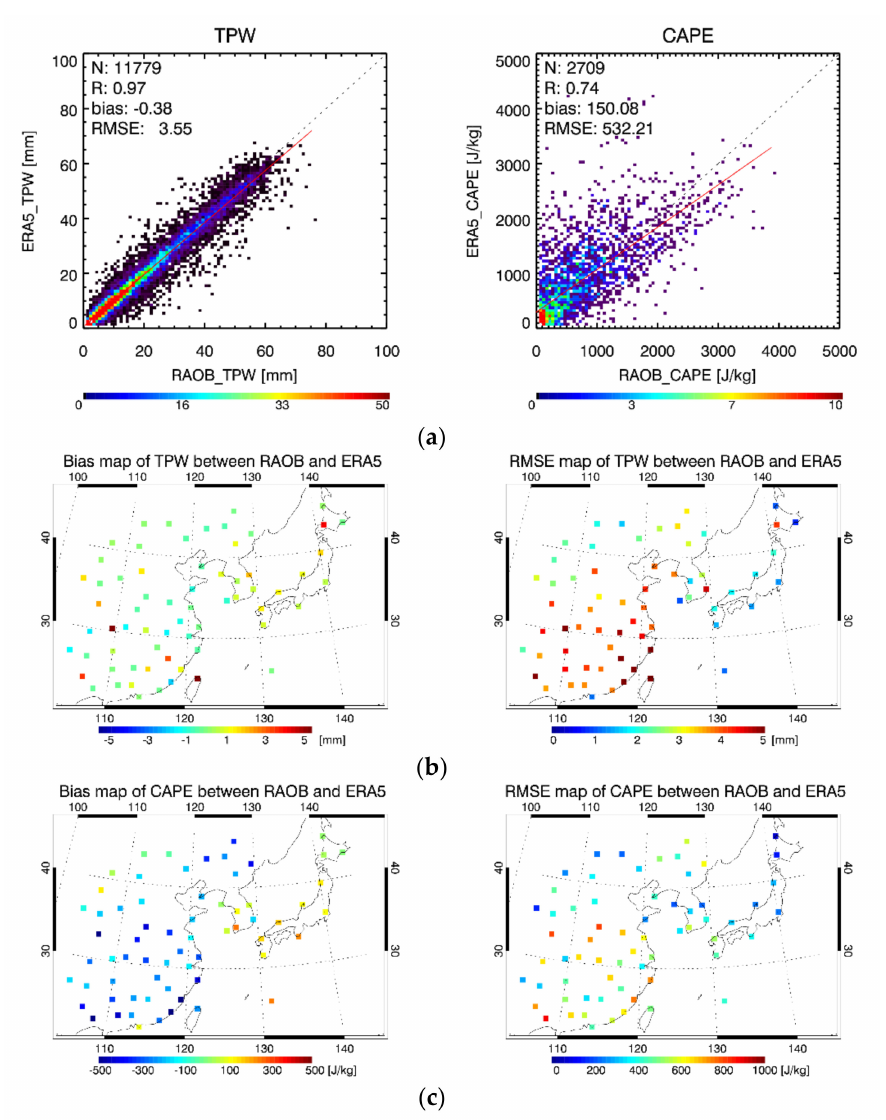
Figure 2. Comparisons between radiosonde observation (RAOB) TPW and ERA5 TPW in Northeast Asia for about one year (25 July 2020 to 24 July 2021). A total of 65 RAOB stations are used to produce the collocation dataset between RAOB TPW and ERA5 TPW over clear-sky conditions. The comparison results between RAOB TPW and ERA5 TPW are represented as ( a ) scatter plots (the color depicts the density and the red line represents a regression line) and error map of ( b ) TPW and ( c ) CAPE (the color represents the magnitude of the